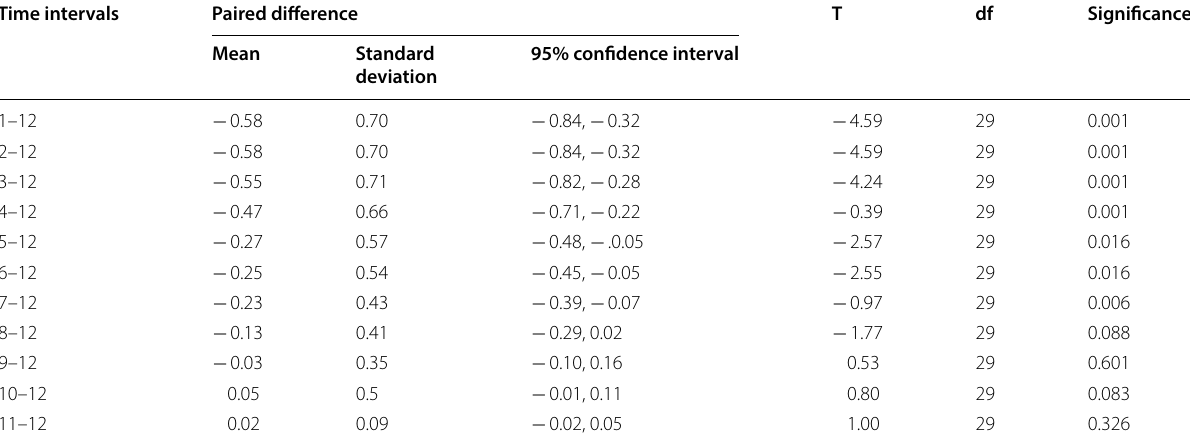
Table 4 EDSS scores in the control group in each time intervals Time intervals Paired difference